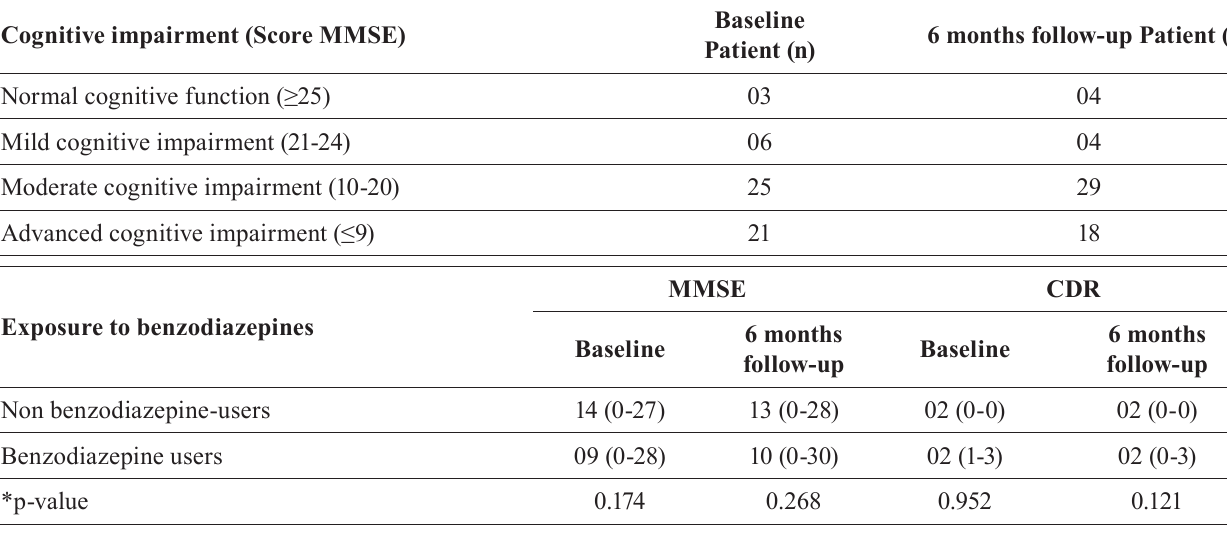
TABLE V - A ssessment of cognitive impairment of patients with Alzheimer’s disease (n=55) trough cognitive screening tests Mini Mental State Examination (MMSE) and Clinical Dementia Rating (CDR) and impact of chronic benzodiazepine use on these parameters performed by the Medication Therapy Management (before-after), Araraquara